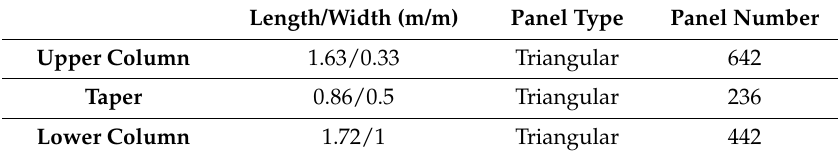
Figure 8. The mesh discretization of the OC3-Hywind spar/UMaine-Hywind spar with triangular panels. (Unit: m). Table 2. Panel properties of the wetted hull for the OC3-Hywind spar/UMaine-Hywind